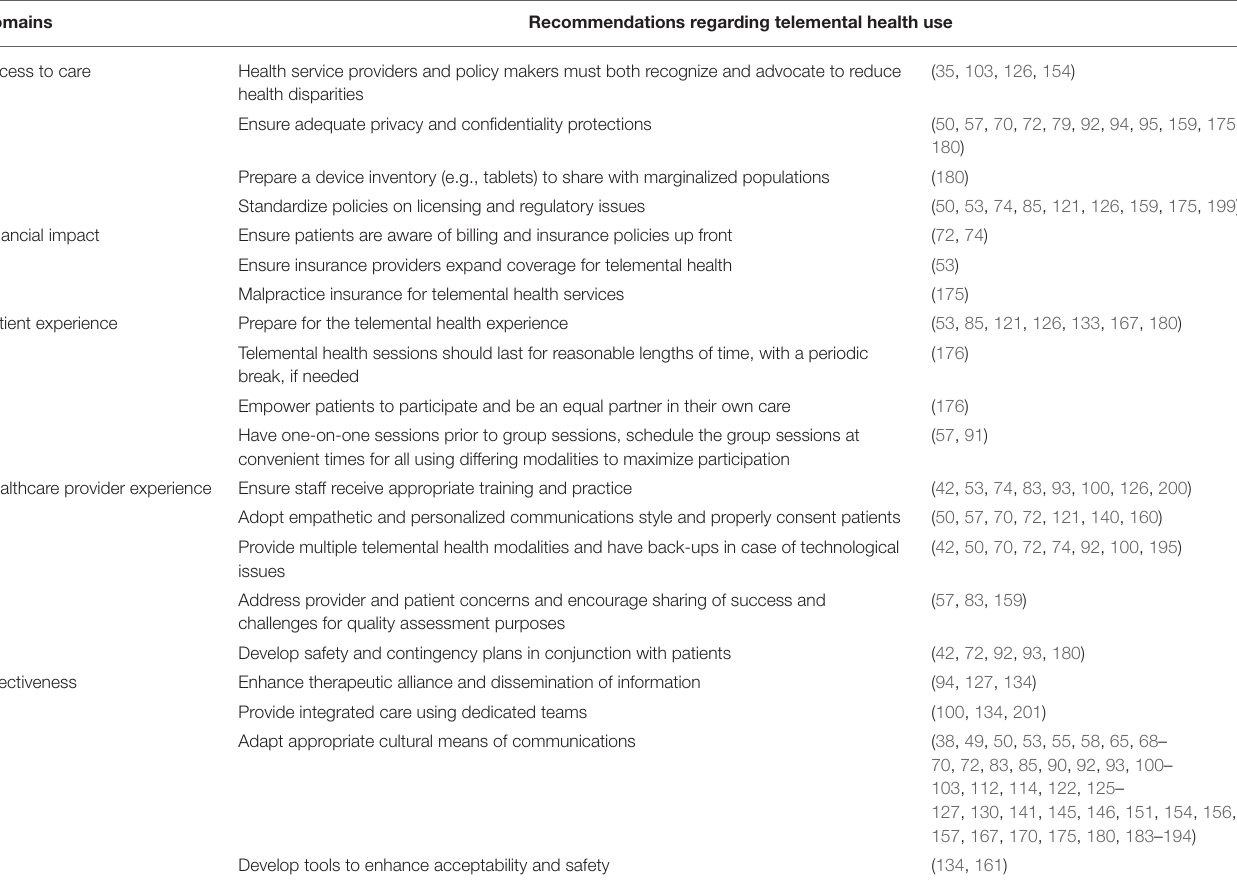
TABLE 3 | Recommendations to enhance telemental health, classified by the NQF framework domains.